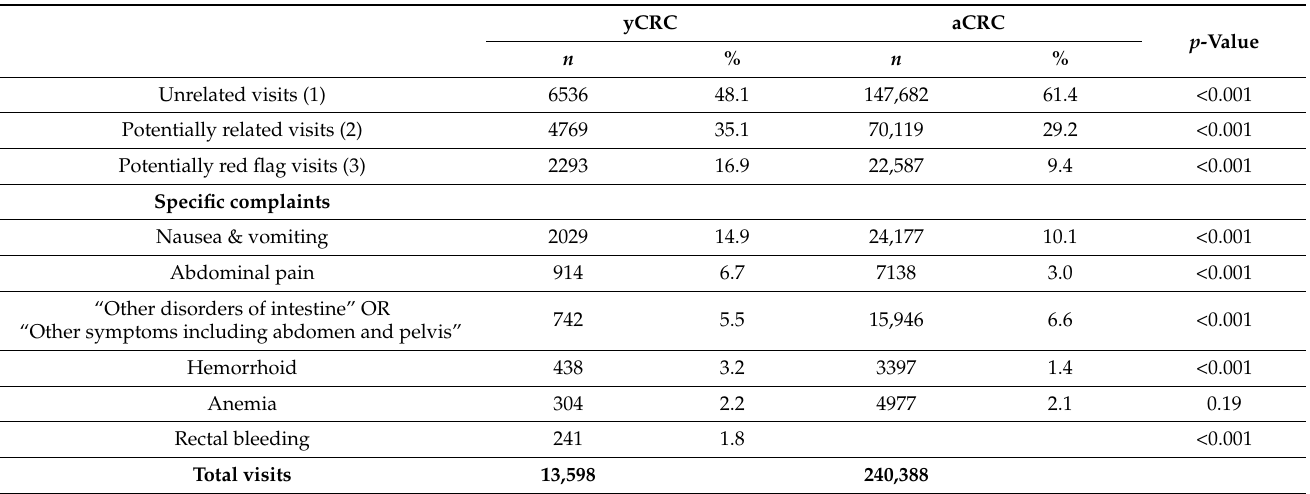
Table 4. Most frequent presenting complaints * for outpatient visits during prediagnosis year-1 for yCRC and aCRC